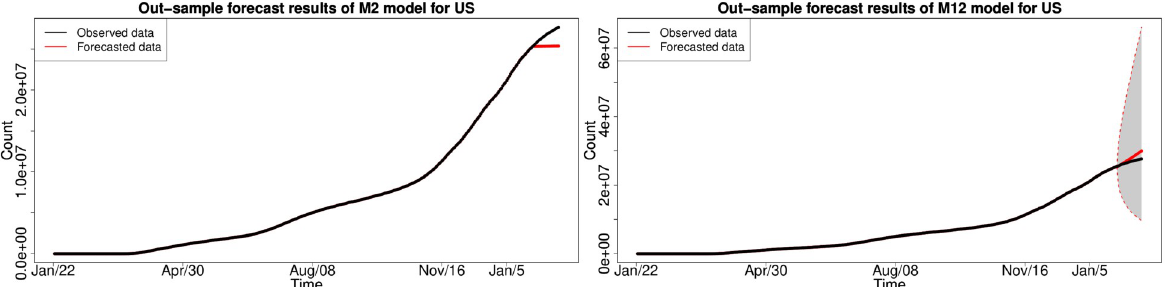
Fig 18. Out-of-sample forecast results for the United States. Out-of-sample forecast plot for the US by Model 2 (left) and Model 12 (right).